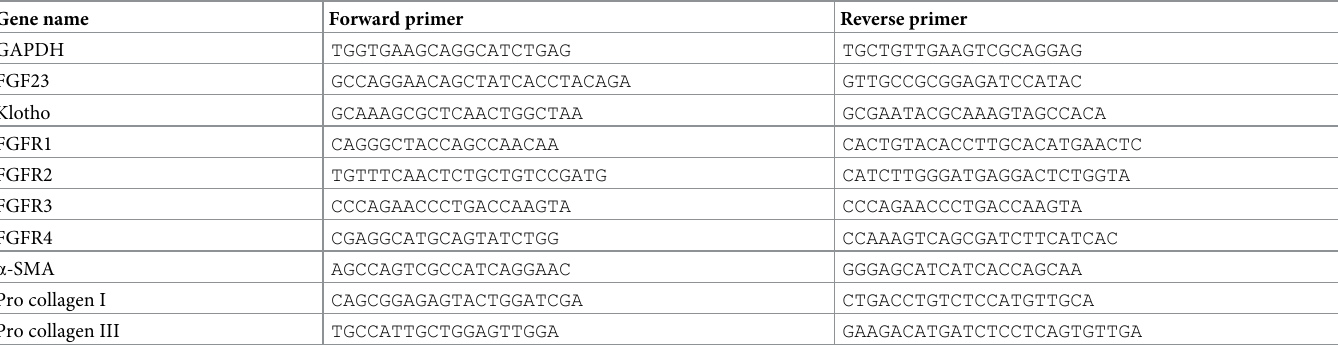
Table 1. List of primer sequence used for